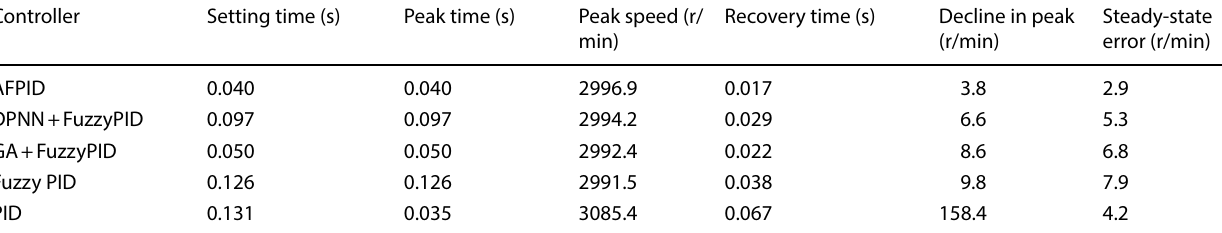
Table 4 The performance indexes under the condition of fix load disturbance Controller